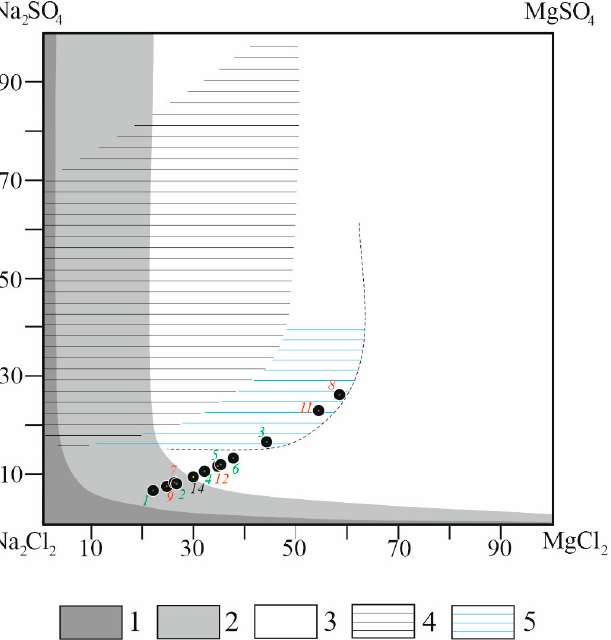
Figure 11. Diagram of Na 2 Cl 2 –MgCl 2 –MgSO 4 –Na 2 SO 4 with crystallization fields of solid phases, which are products of the reaction of brines of the sulfate system with calcium bicarbonate [62].